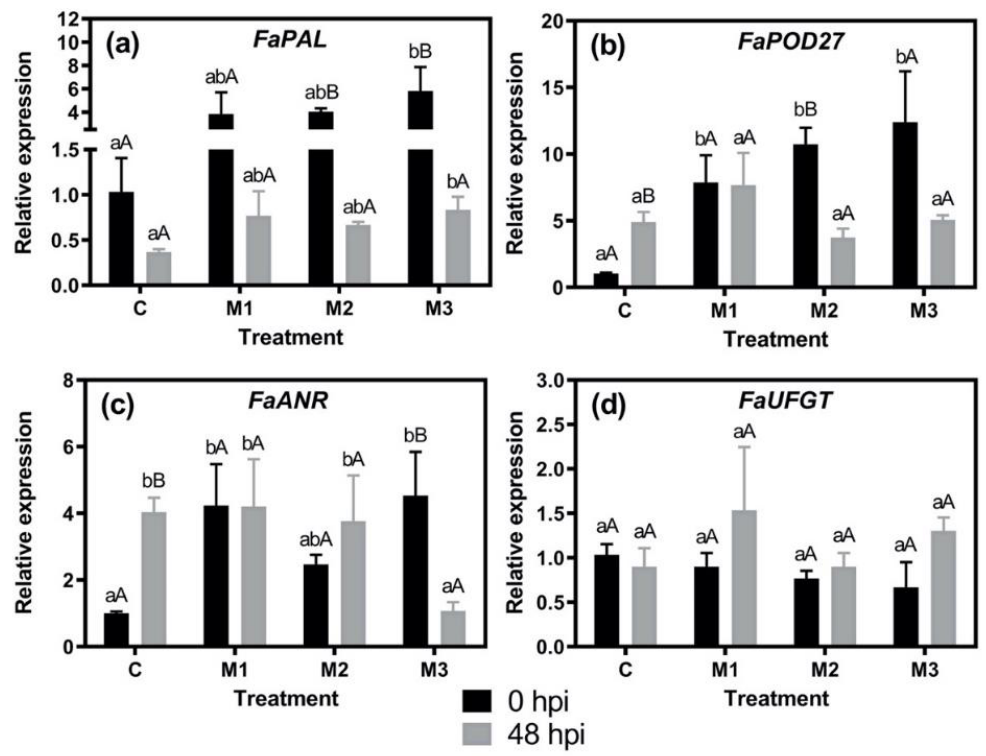
Figure 3. Expression profiles of genes encoding phenylpropanoid pathway-related enzymes of di ff erent methyl jasmonate (MeJA)-treated strawberry ( Fragaria × ananassa ‘Camarosa’) fruit at 0 and 48 h post inoculation (hpi) with Botrytis cinerea conidia ( + Bc fruits). Changes in the relative expression of ( a ) FaPAL , ( b ) FaPOD27 , ( c ) FaANR , and ( d ) FaUFGT in fruit subjected to di ff erent methyl jasmonate treatments (C, M1, M2, and M3) and analyzed at 0 and 48 hpi. Di ff erences between means ± standard error (SE) ( n = 6) were determined by ANOVA and LSD test ( p < 0.05). Di ff erent capital letters indicate significant di ff erences between 0 and 48 hpi on each treatment. Di ff erent lower-case letters indicate significant di ff erences between treatments on each time (0 or 48 hpi). For experimental details, see the Materials and Methods section.